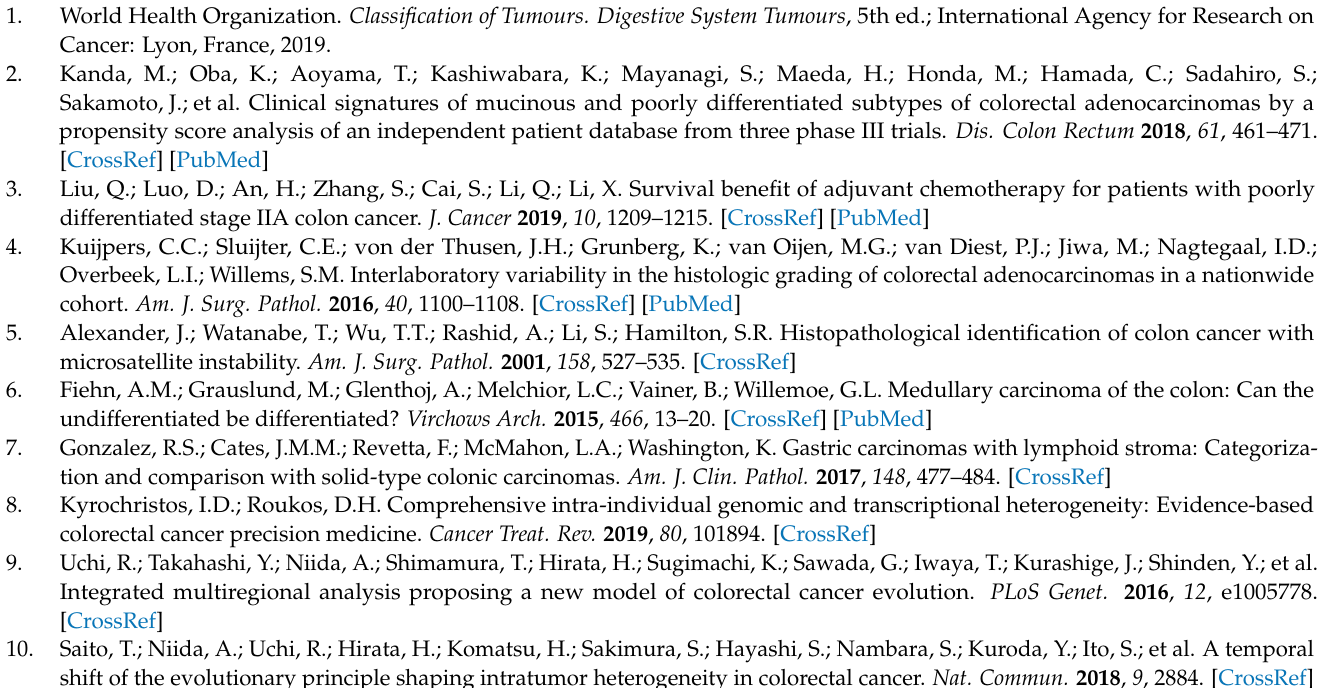
Figure S4: Most significant different genes mutated between well-differentiated and undifferentiated microsatellite unstable tumors in Giannakis’ series, Figure S5: Evolutionary trees of all high-grade colorectal carcinomas included in our series, Figure S6: Representative positive and negative figures of immunohistochemical staining, Table S1: Microsatellite instability analyzed by patient, Table S2: Clinicopathological data by patient, Table S3: Complete set of mutations detected in glandular and solid areas, Table S4: Immunohistochemistry antibodies, Table S5: Primers designed for the validation of fusions and their location in the target, Table S6: Differences between MSI and MSS CRCs according to stage in Giannakis’